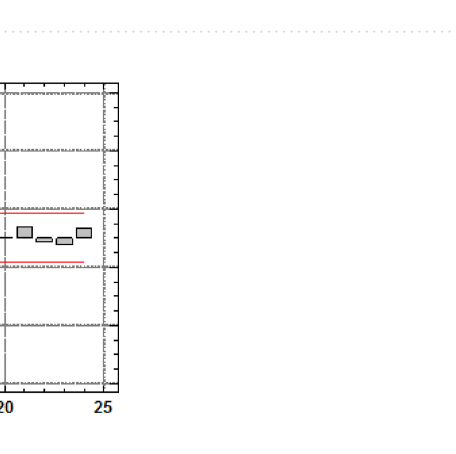
Figure 9. Estimated autocorrelations for various lags for the number of defects (density) in 1-m segments of the 7–8 belt section, for the 1st measurement 5,42 .